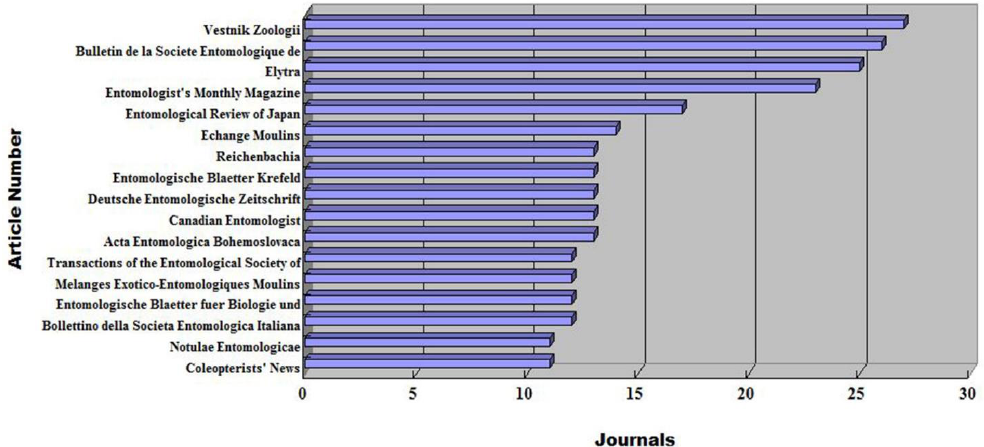
Figure 2. The distribution of articles by journal. Table 2. The distribution of articles by primary authors, years, and countries.